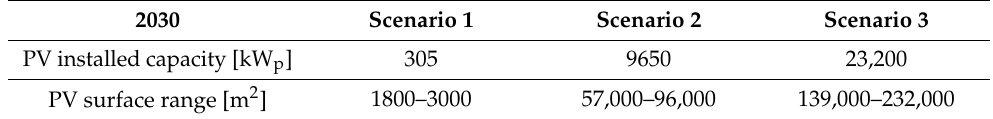
Table 1. Input data for the energy system scenarios in Procida Municipality.